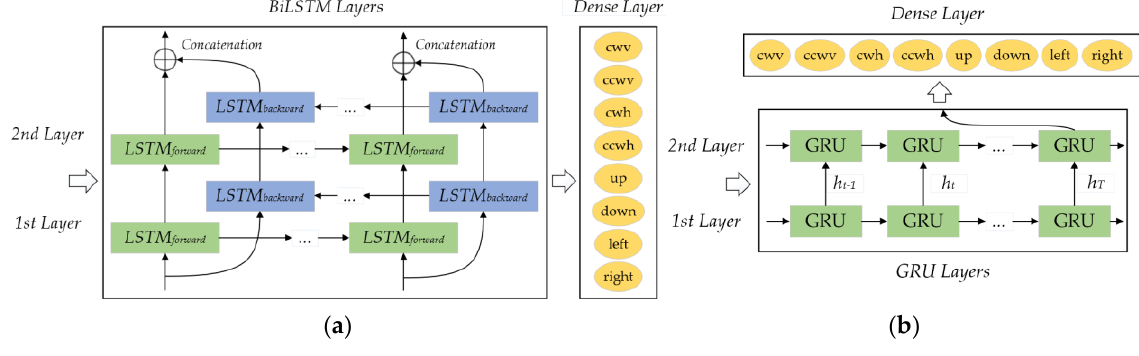
Figure 9. Architectures of ( a ) RNN – BiLSTM and ( b ) RNN – GRU. The RNN-BiLSTM and RNN-GRU were implemented using the Keras library. The minibatch approach with a mini-batch size of 64 was used for training. The initial weights of the network were generated randomly. The learning rate was set as 0.001 and the number of training iterations to 40. The trained RNN-BiLSTM and RNN-GRU model classified the data as many-to-one, recognizing the input data as a single label. The inertial data collected from the LPMS-B2 module was divided into 70%(140) as a training dataset and the remaining 30%(60) as a testing dataset. The training process is 40-epochs. Tables 4 and 5 give the confusion matrix of BiLSTM and GRU, respectively, where the row labels are actual and the column labels are predictions. We can get the average classification accuracy using RNN-BiLSTM of 98.0% and the RNN-GRU of 97.7%. That average classification accuracy of RNN-BiLSTM is better than that of 96.06% using the public data and 94.12% using the collected data reported in [16]. Likewise, the accuracy of RNN-GRU is higher than their 95.34% with their collected data but lower than their 99.16% with the public data. Considering that the data sets used are fundamentally different, it can be assumed that the recognition accuracy achieved by the two articles is similar. Table 4. Confusion matrix of BiLSTM.